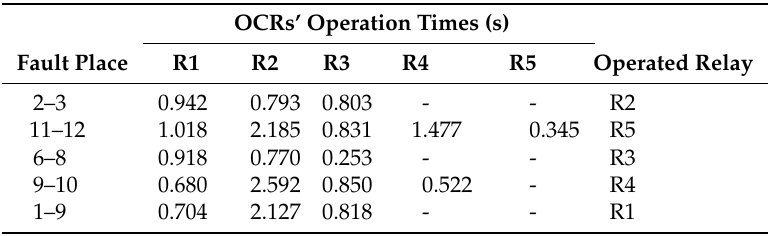
Table 4. Faulty zone detection. OCR, over current relay.